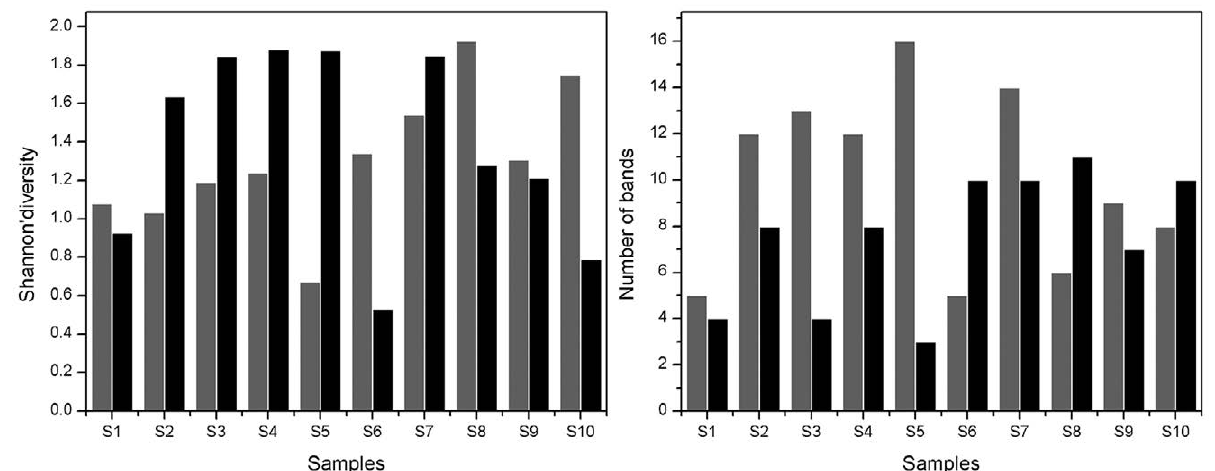
Fig. 4. – Comparison of the cyanobacterial diversity of sediment samples (H ’ was calculated on the basis of the number and relative intensities of bands on the gel track). Grey columns stand for samples in wet season; black columns stand for samples in dry season.